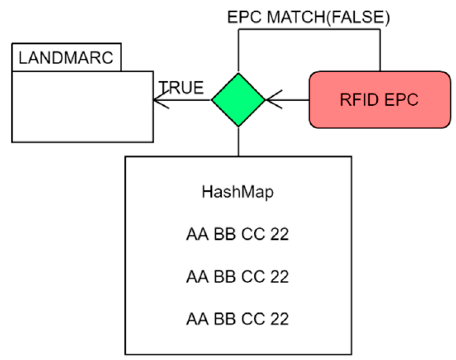
Figure 4. Card filter implementation.